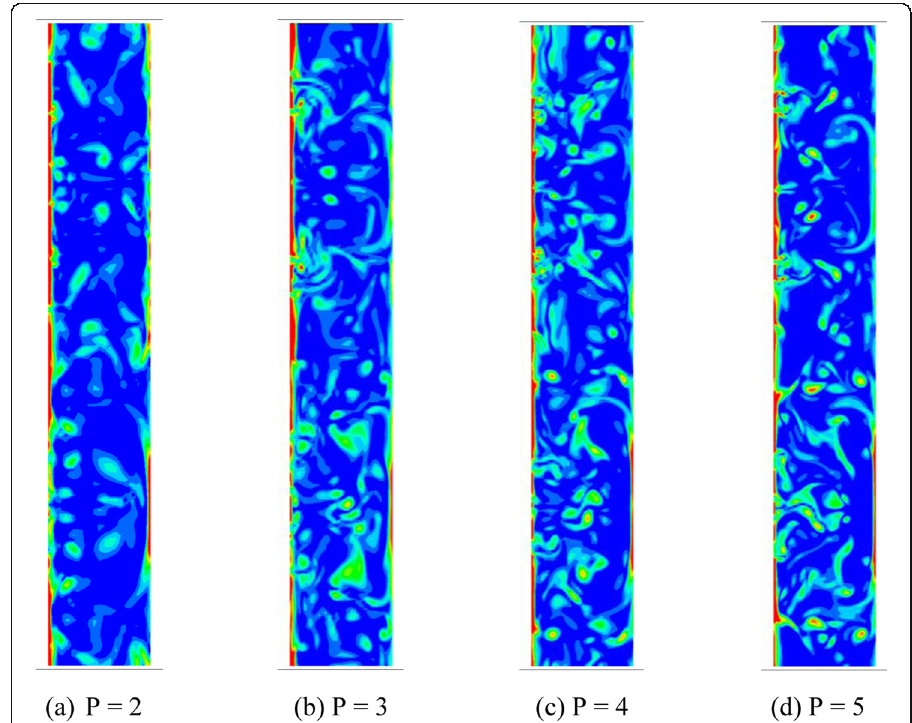
Fig. 8 The vorticity distributions at t 4 computed with different schemes